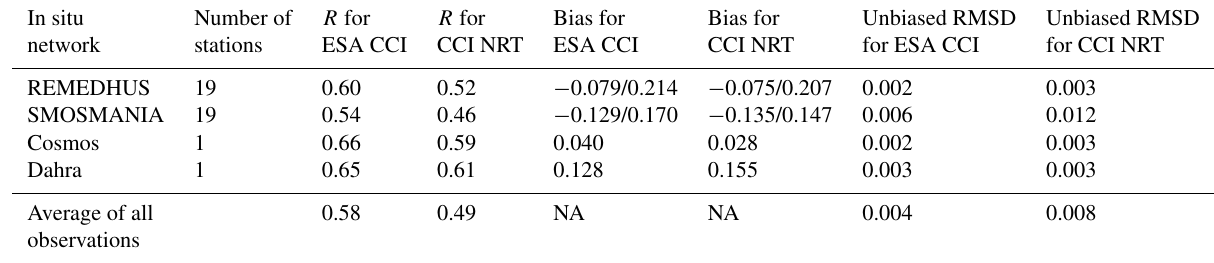
Table 1. Statistical scores for ESA CCI SM/CCI NRT and in situ stations/networks (maximum depth 0.1m) in Spain, France, Kenya and Senegal for 2013 (for the REMEDHUS and SMOSMANIA networks the table includes the bias range from minimum to maximum). In situ Number of R for R for Bias for